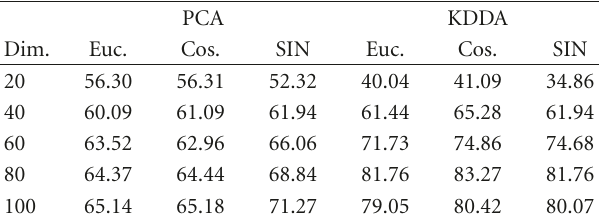
Table 2: Face identification results (in %).